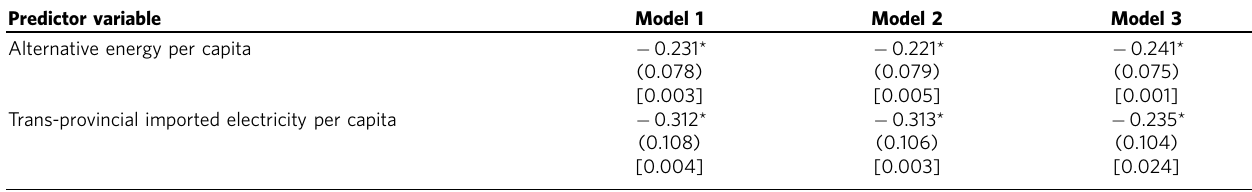
Table 1 | Displacement coefficients of alternative energy and trans-provincial imported electricity in China estimated from models of electricity supply.